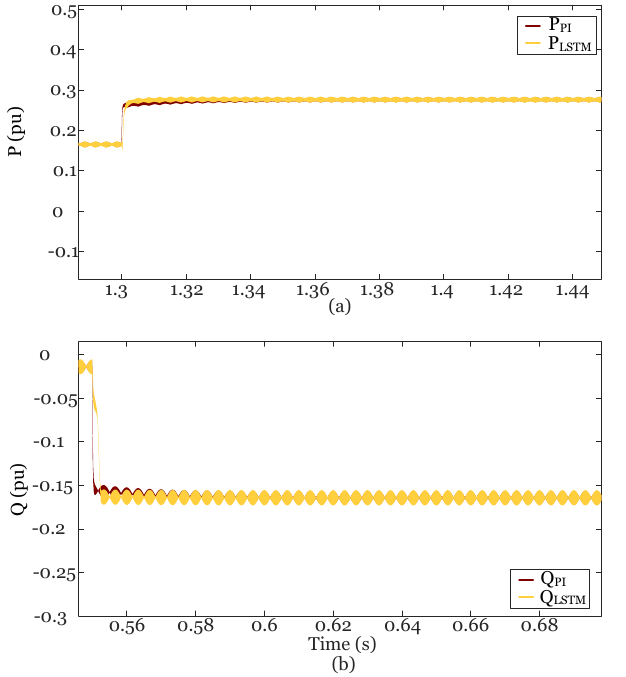
Figure 15. Real and reactive power response for a lower SCR. ( a ) Real power; ( b ) Reactive power.